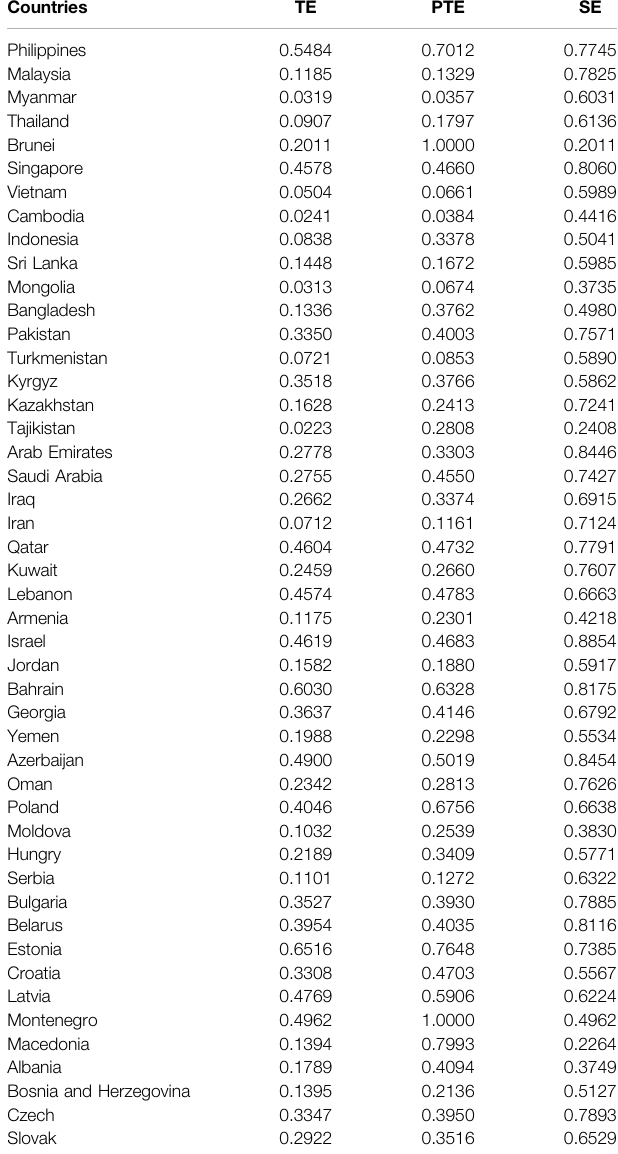
TABLE 5 | Estimated results of green investment ef fi